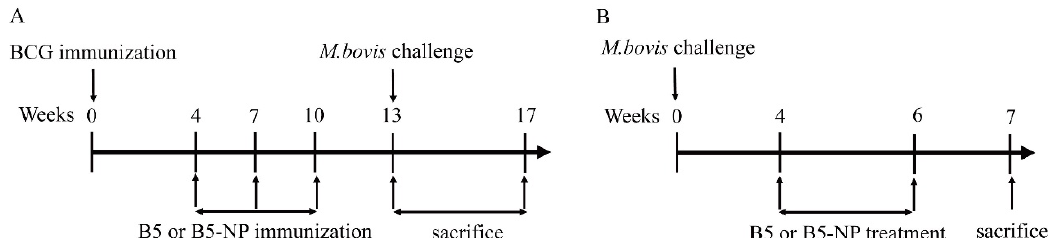
Figure 1. Experimental design for evaluation of immunoregulatory and antimicrobial activities of B5 protein nanoparticles (B5-NPs). ( A ) Flow chart depicting the pre-exposure strategy. Groups of BALB / c mice (n = 10 per group) were immunized subcutaneously with 10 6 CFU of Bacillus Calmette–Gu é rin (BCG) in 100 µ L of PBS. At four weeks before infection, mice were immunized intranasally with B5 (2.5 mg / kg) or B5-NPs (50 mg / kg) three times every three weeks. ( B ) Flow chart depicting the post-exposure strategy. Mice were challenged intranasally with 110 CFU of M. bovis . After 4 weeks, the mice were treated subcutaneously with B5 (5 mg / kg), B5-NPs (100 mg / kg), or respectively combined with rifampicin (RIF) (10 mg / kg) until week